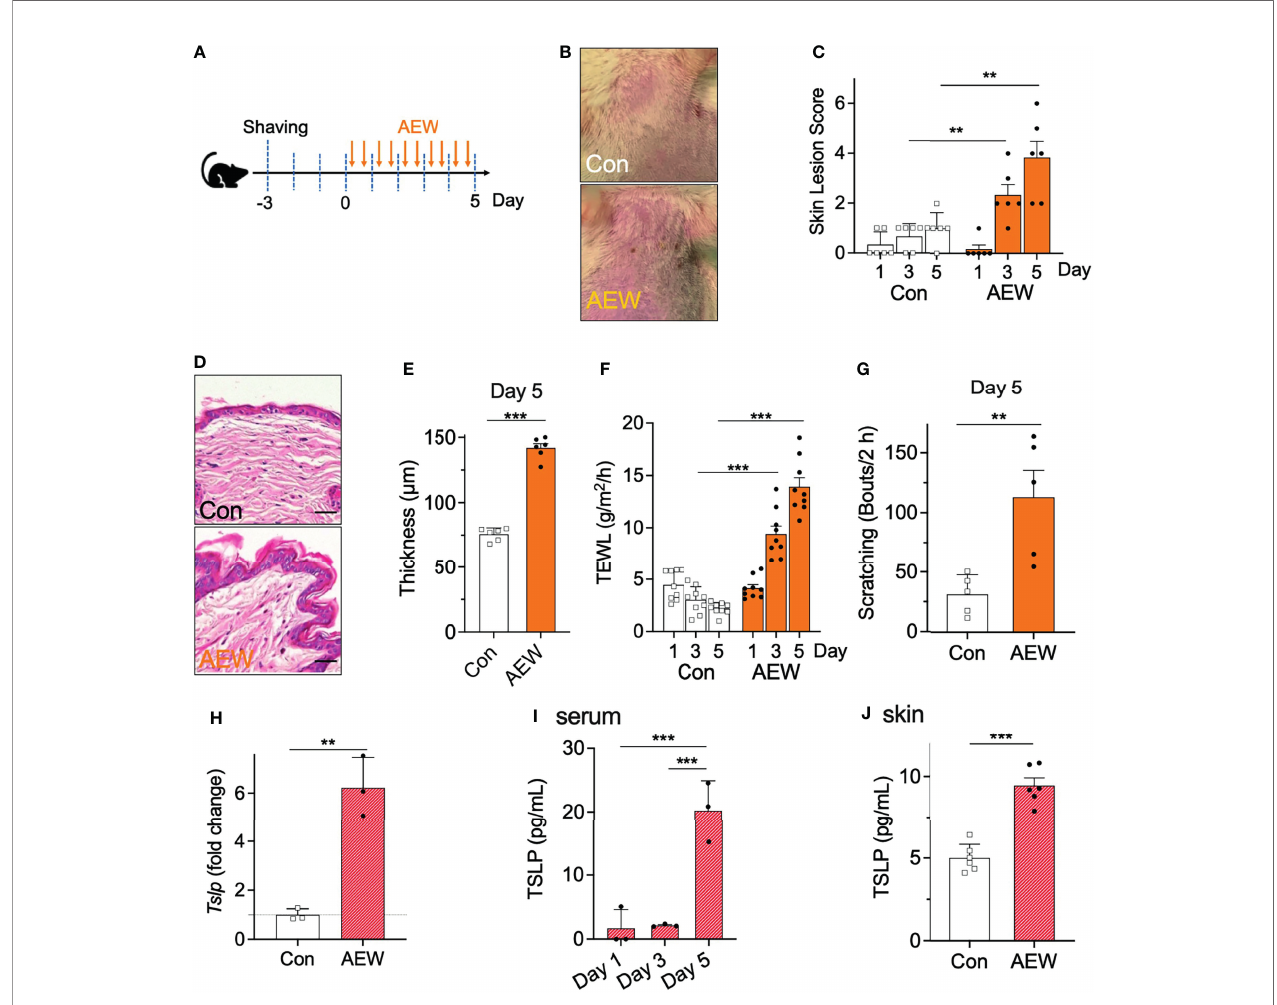
FIGURE 1 | Development of dry skin symptoms and increased TSLP levels in AEW-treated mice. (A) Schematic illustration of the treatment protocol with AEW. (B) Images of the mouse skin, with or without AEW treatment. (C) A graph of the skin lesion scores of the control (n = 6) and AEW-treated mice (n = 6), as measured on different days. (D) Representative H&E-stained images of the skin tissues collected on day 5. (E) The thickness of the epidermis signi fi cantly increased on day 5 following AEW treatment (n = 6), compared to that of the control (n = 6). (F) The values of TEWL signi fi cantly increased on days 3 and 5 following AEW treatment (n = 9). (G) The spontaneous scratching bouts signi fi cantly increased in the AEW-treated mice (n = 5) on day 5, compared to those of the control (n = 5). (H) The transcriptional levels of Tslp signi fi cantly increased in the keratinocytes of AEW-treated mice. (I) The serum levels of TSLP signi fi cantly increased in the AEW- treated mice (n = 3) on day 5, compared to those of the control (n = 3). (J) The skin levels of TSLP increased on day 5 after treatment with AEW, compared to those of the control (n = 6). ** p < 0.01, *** p <